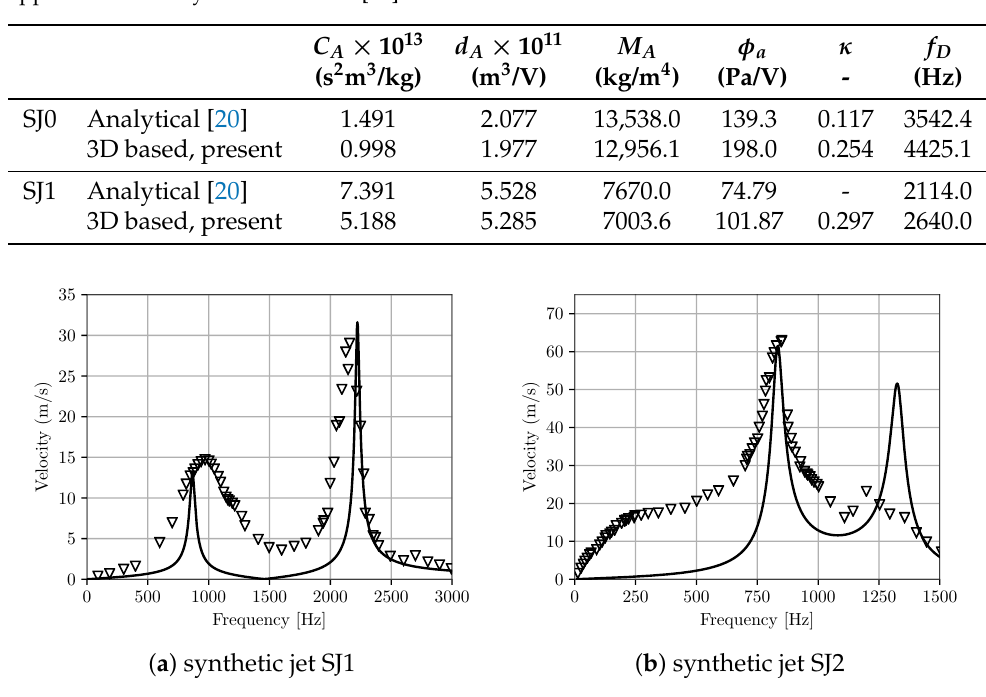
Figure 10. Velocity at the orifice with frequency for two synthetic jet set-ups. Comparison between the present LEM prediction with experiment [20]. The lines are the numerical prediction using the proposed LEM approach and the triangle symbols are experimental